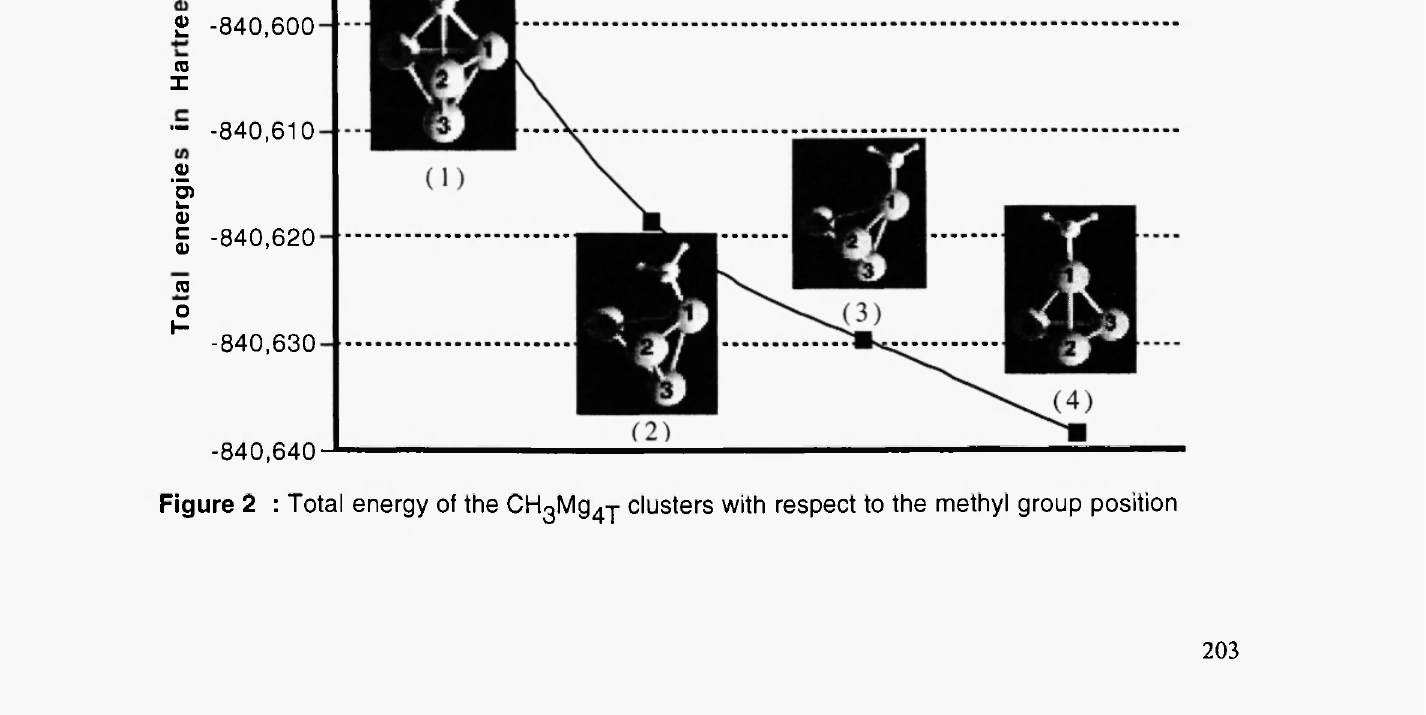
Figure 2 : Total energy of the CHgMg 4 y clusters with respect to the methyl group position